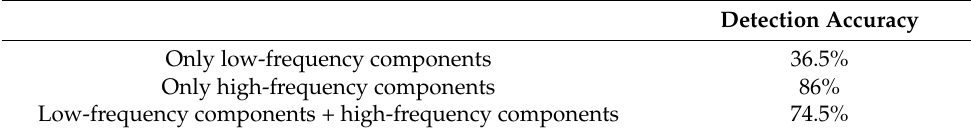
Table 1. The influence of the detection model under a combination of different frequency domain components.